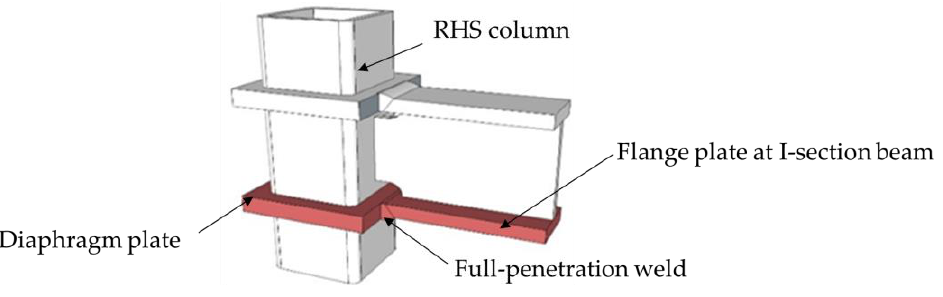
Figure 1. Target parts of the experiments.